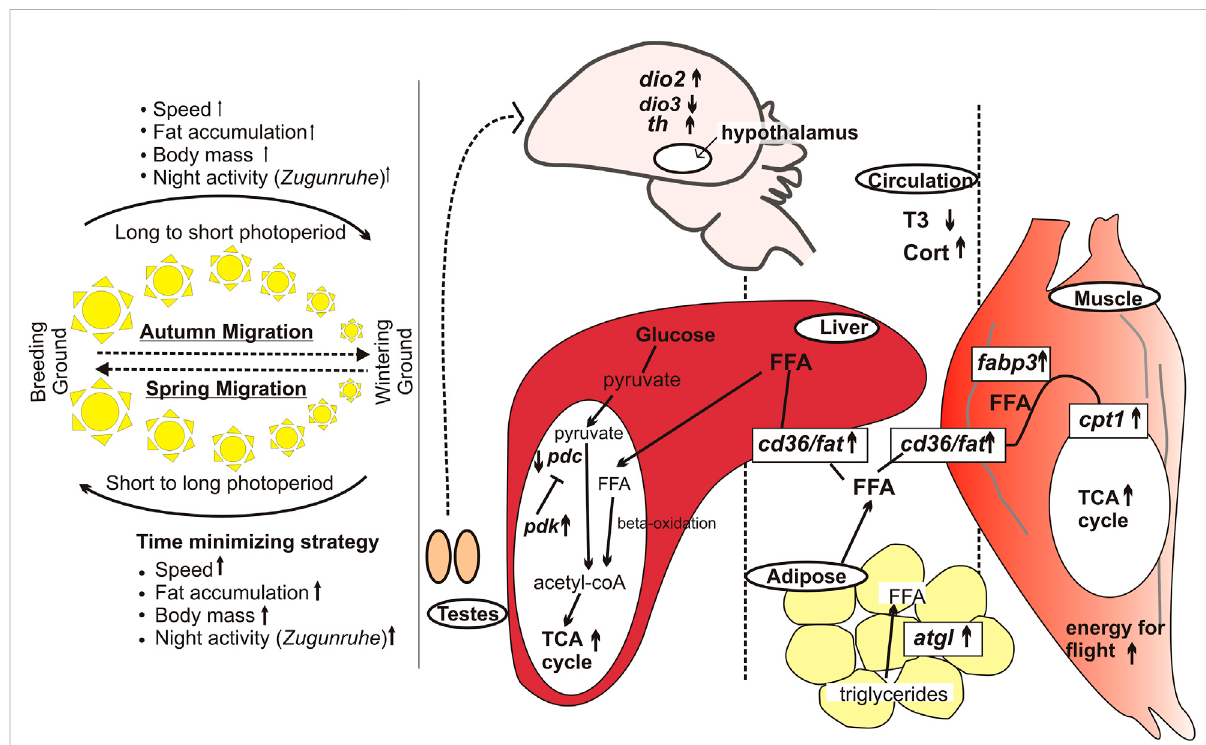
FIGURE 1 Differences in spring and autumn migrations, based on studies in captive migratory redheaded buntings. Left panel: Phenotypic changes associated with spring and autumn migrations. The thickness of arrows re fl ects differences in magnitude of the photostimulated response. The sun cartoons inthemiddle indicate thedirection ofphotoperiodchange.Rightpanel: Molecular changesinthehypothalamus, liver, muscleand adipose tissues in spring compared to the autumn migration. In spring, migrants show elevated plasma Cort and reduced T3 levels, and reciprocal switching of dio2 and dio3 , and increased th expression. The adipose triglycerides are converted into free fatty acids, which are up taken from circulation mediated by the enzymes and proteins encoded by cd36 / fat , fabp3 and cpt1 genes. Hepatic pdc and pdk encoded enzymes regulate the fueluse.Thearrowandthelineendingwithbarrepresentactivationandinhibitorypathways,respectively.Upwardarrowsindicateupregulatedgene expression in spring compared with that in the autumn migration (Sharma et al., 2018a; Sharma and Kumar